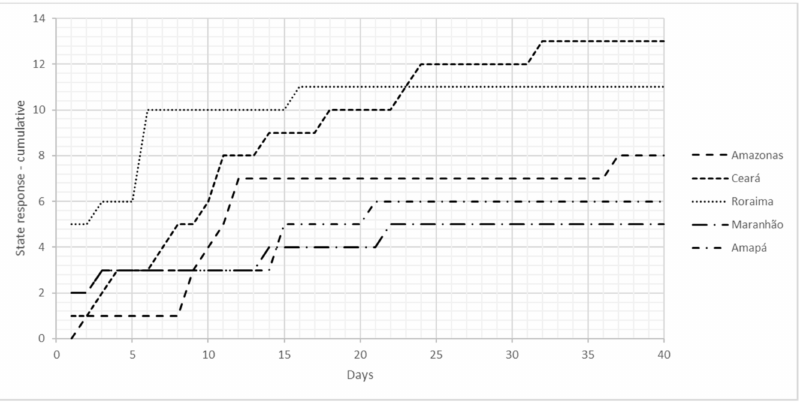
Figure 1. Cumulative measured responses of states to the coronavirus pandemic in the first 40 days.